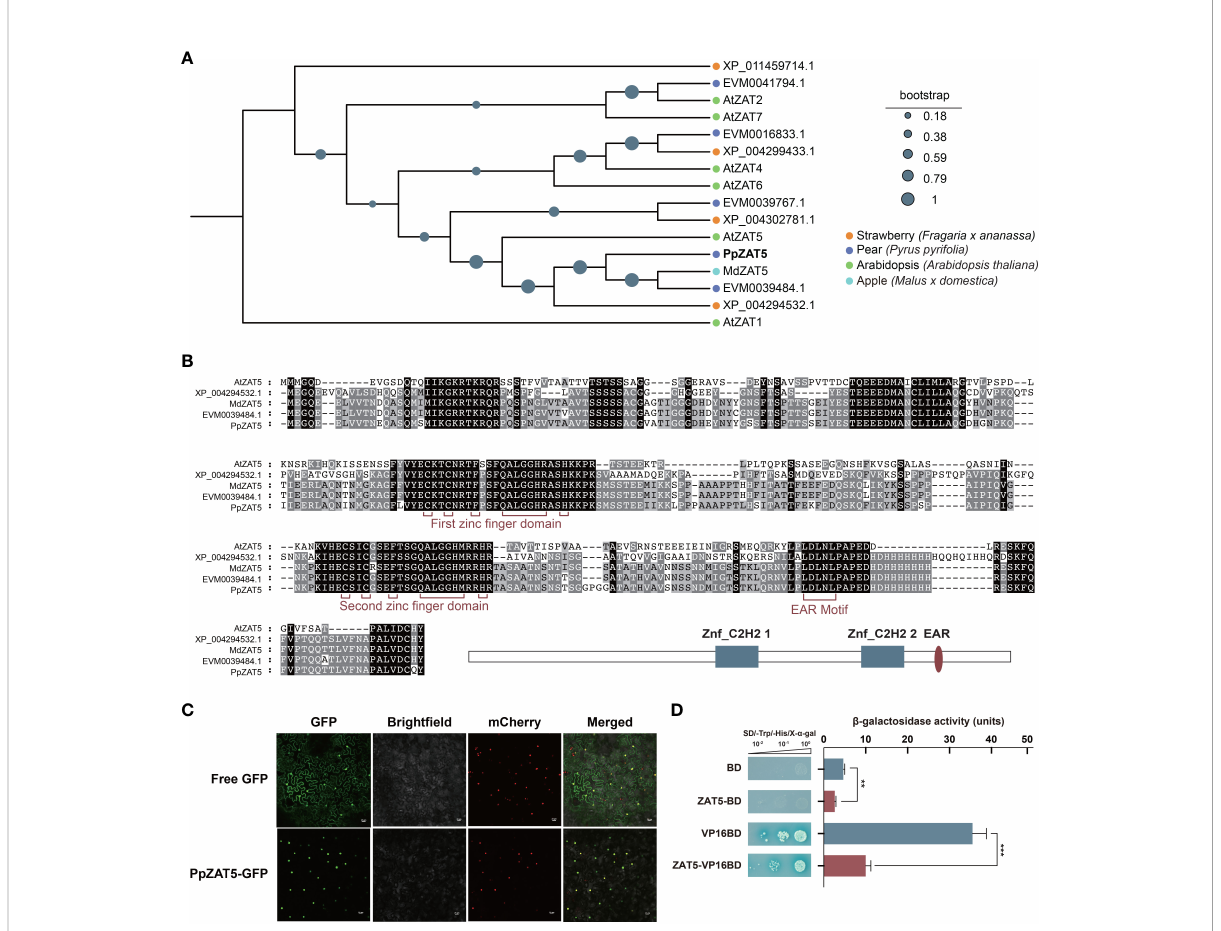
FIGURE 1 Bioinformatics analysis and trans-acting activity of PpZAT5. (A) Phylogenetic analysis of the C2H2-type zinc fi nger proteins from pear and other plant species obtained through blast algorithm using Arabidopsis ZAT1 to ZAT7 as queries. Pear ( Pyrus pyrifolia ); Apple ( Malus x domestica ): MdZAT5(MD03G1128800); Arabidopsis ( Arabidopsis thaliana ): AtZAT1(AT2G46800.1), AtZAT2(AT2G17180.1), AtZAT4(AT2G45120.1), AtZAT5 (AT2G28200.1), AtZAT6(AT5G04340.1), AtZAT7(AT3G46090.1); Strawberry ( Fragaria x ananassa ). (B) Alignment of C2H2-type zinc fi nger proteins from pear, strawberry and apple. (C) Subcellular localization of PpZAT5 expressed in tobacco leaf cells. Scale bars = 25 m m. (D) Trans-acting activity of PpZAT5 transformed into yeast cells. The b -galactosidase activities re fl ected the trans-acting activities. Error bars for trans-acting activity represent the standard deviation of three independent experiments each. Asterisks indicate signi fi cant differences (two-tailed Student ’ s t -test, **P < 0.01, ***P <